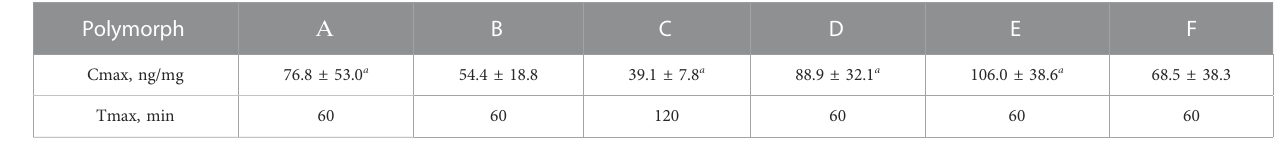
TABLE 9 C max and T max values for brain tissue